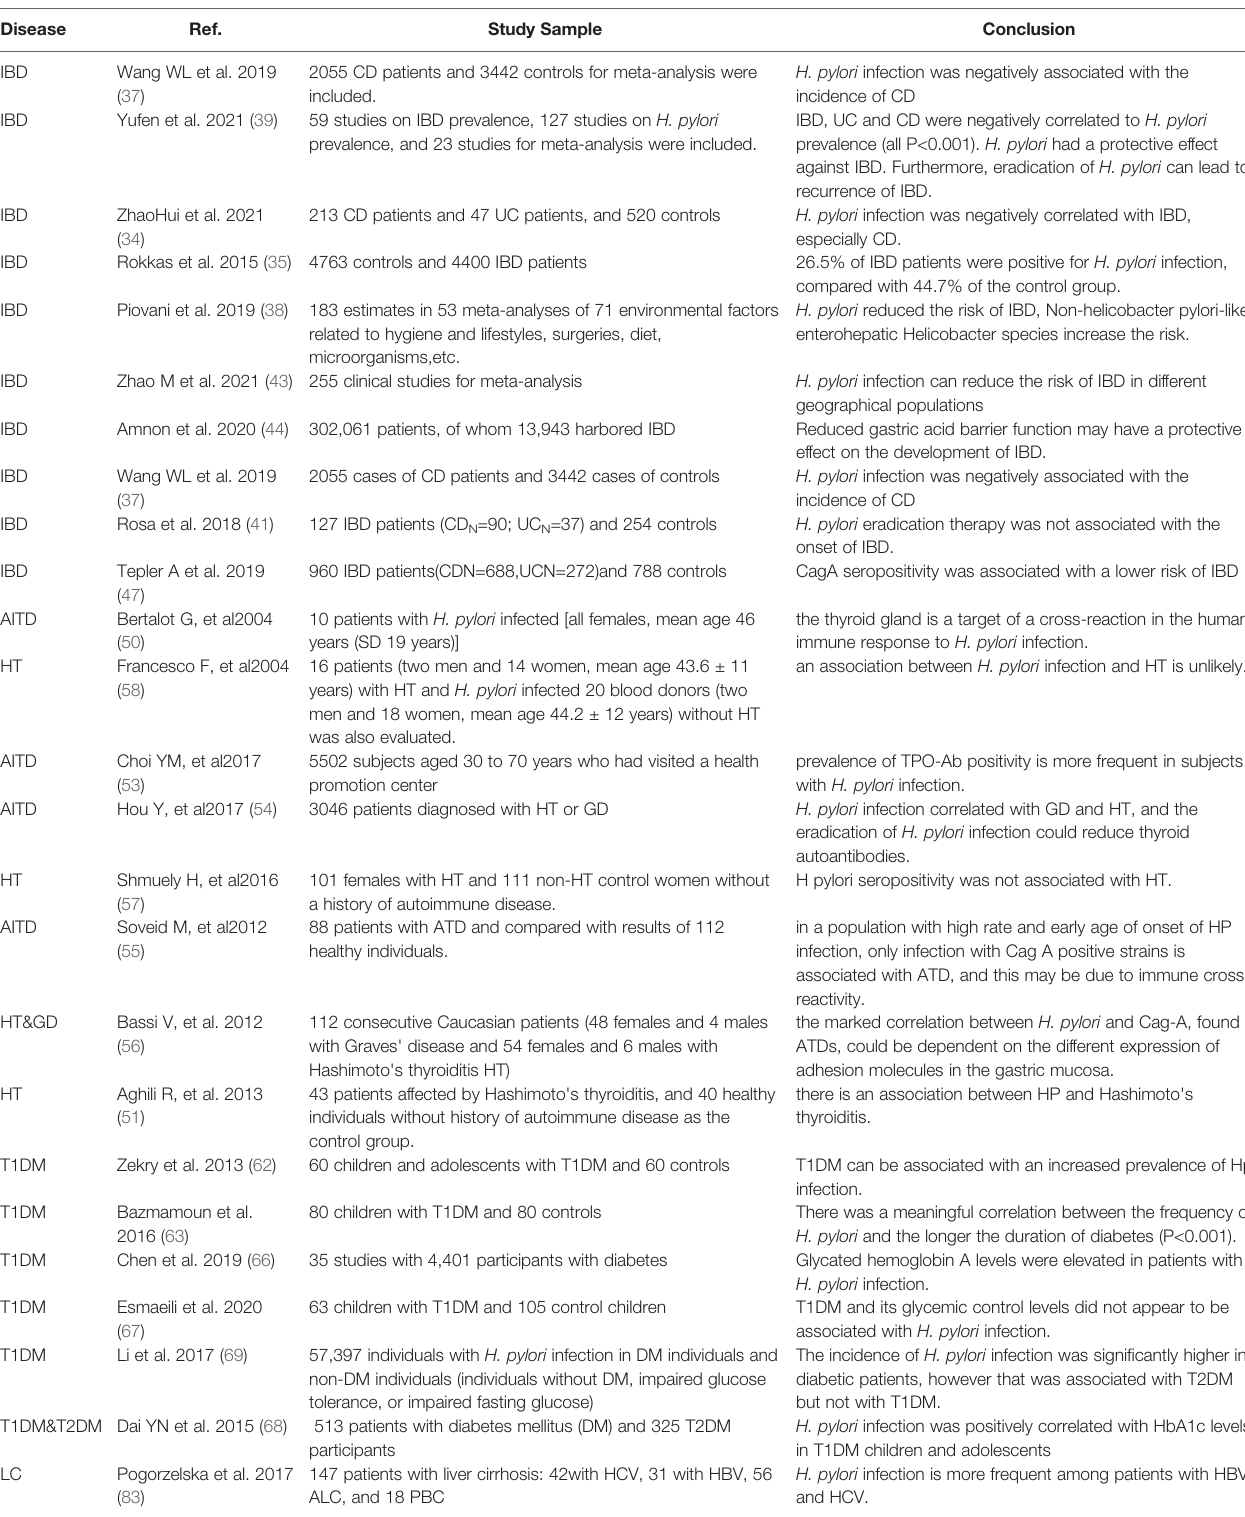
Evidences for or against H. pylori associated with autoimmune diseases